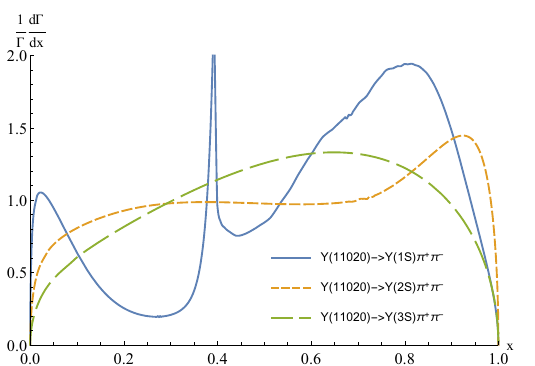
Figure 3. Normalized di ff erential width for the transitions Υ (11020) → Υ ( m 3 S 1 ) π + π − . The variable x ) / ( m Υ (11020) − m Υ ( mS ) − 4 m 2 is defined as x = ( s − 4 m 2 π π